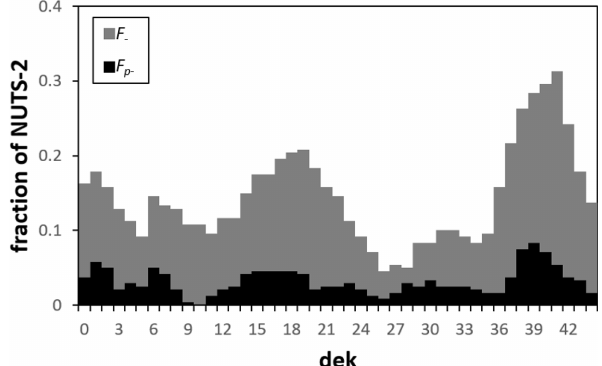
Figure 6. Fraction of NUTS 2 regions for which each dekad is in- cluded in the longest homogeneous period with F p − = 1 (black) or F − = 1